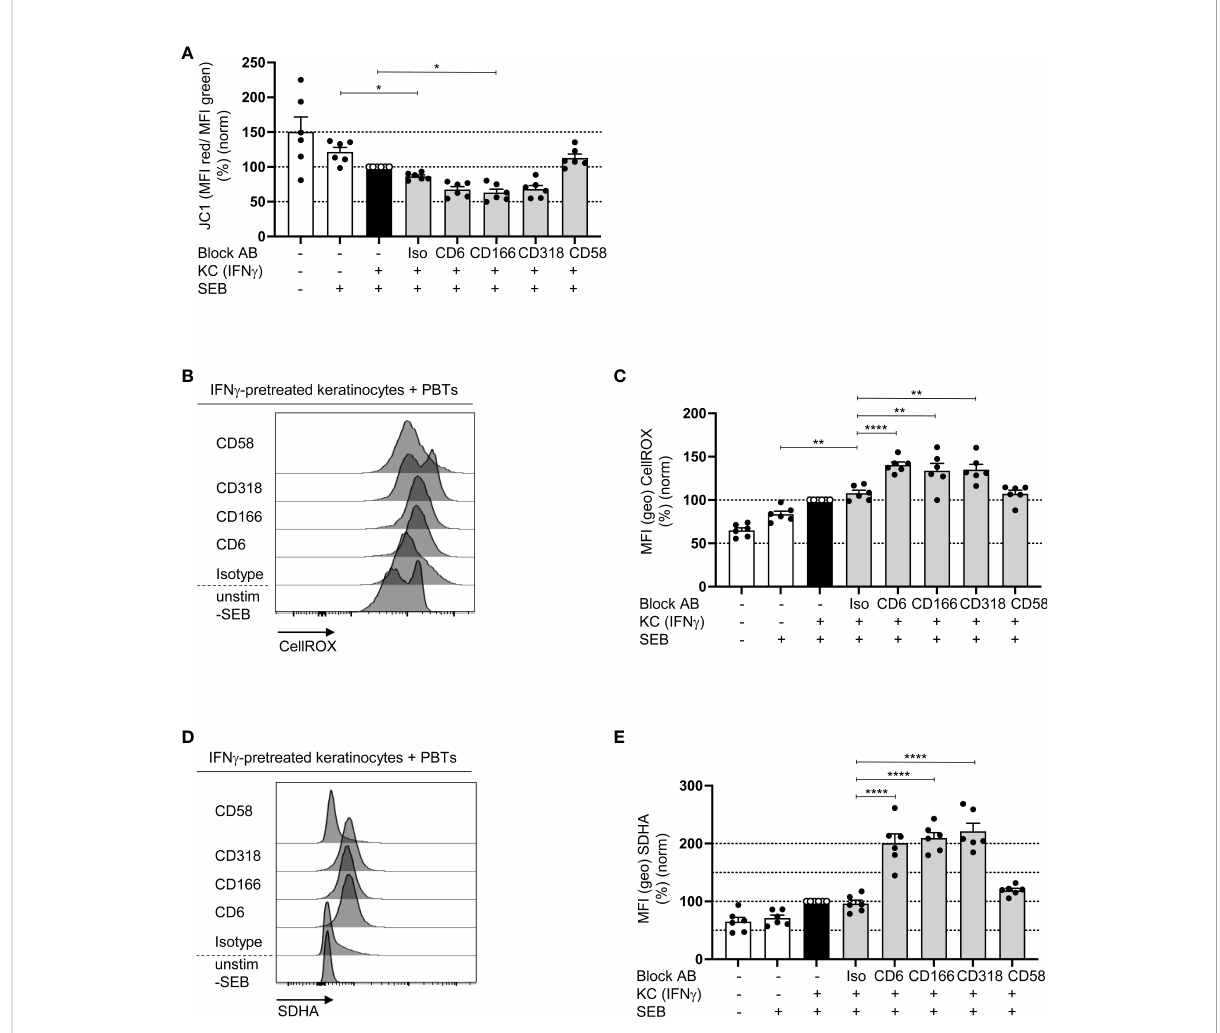
FIGURE 7 Blockade of the interaction between CD6, CD166 or CD318 lowers the mitochondrial membrane potential and increases ROS levels. CD3 + PBTs were cultured for 72 h with untreated KCs (white bars) or IFN g -pretreated KCs (black and grey bars), loaded with SEB and the effects of blocking antibodies against CD6, CD166, CD318 or CD58, or isotype control antibodies (iso) were analyzed. (A) Mitochondrial membrane potential assessed by JC-1 (ratio between aggregates and monomers) after 72 h coculture (n = 6 individual T cell donors). (B, C) Representative histograms (B) and statistical evaluation (C) of intracellular ROS (assessed by CellROX) in PBTs (n = 6 individual T cell donors). (D, E) Intracellular SDHA expression in PBTs. (D) Representative histograms and (E) statistical evaluation (n = 6 individual T cell donors). Data was normalized to PBTs cultured with IFN g -pretreated KCs loaded with SEB (black bar). Data is represented as mean ± SEM. ****=p<0.0001; **=p<0.01;